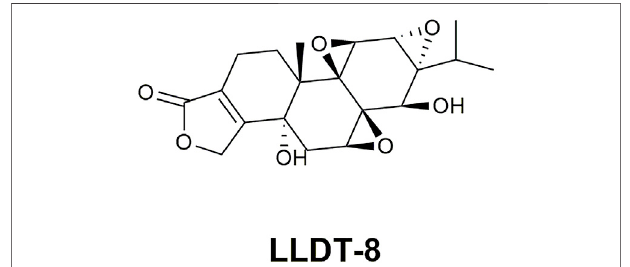
FIGURE 3 | The structural formula of